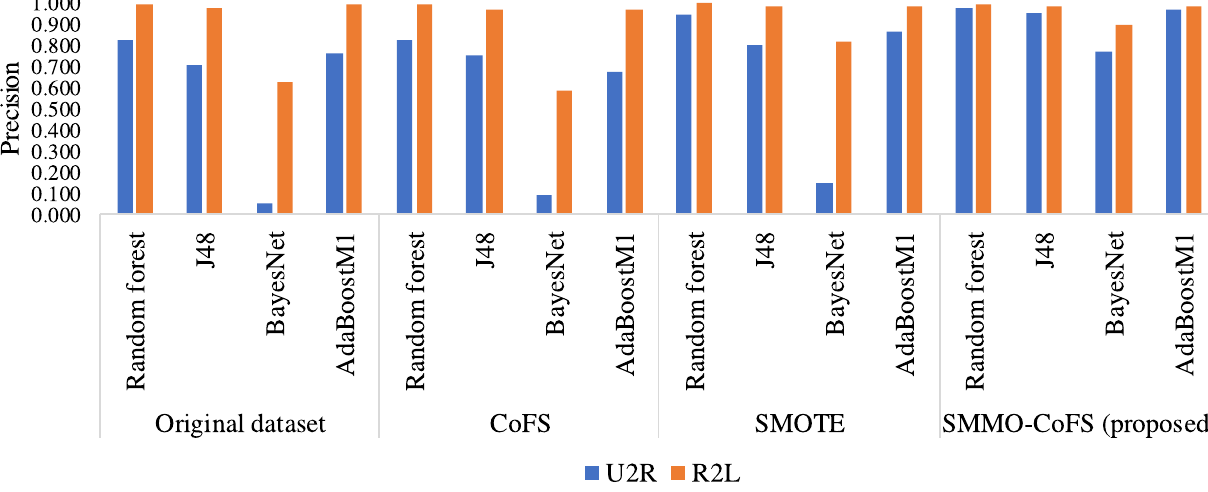
Fig. 5 Performance of SMMO-CoFS with random forest, J48, BayesNet and AdaBoostM1 in terms of precision for U2R and R2L